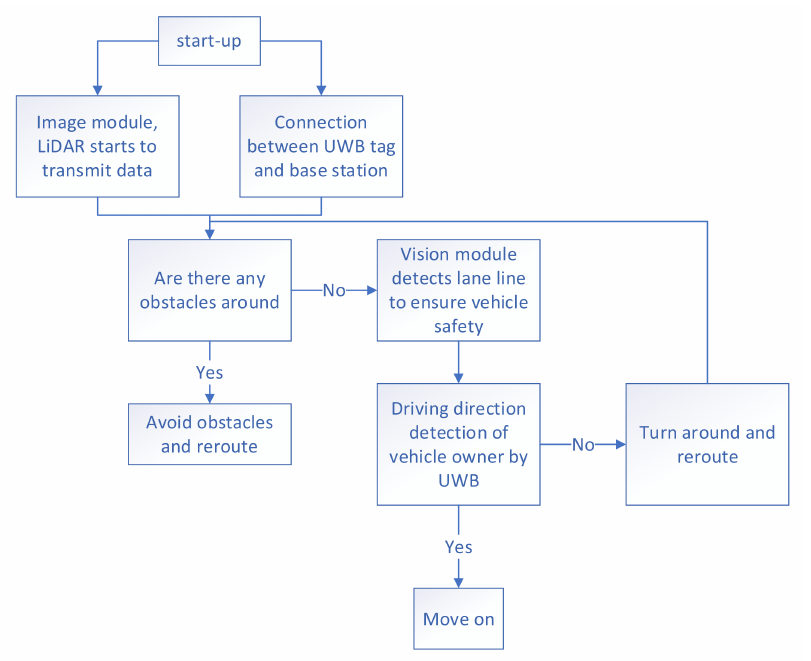
Figure 3. Car-hailing flow chart.